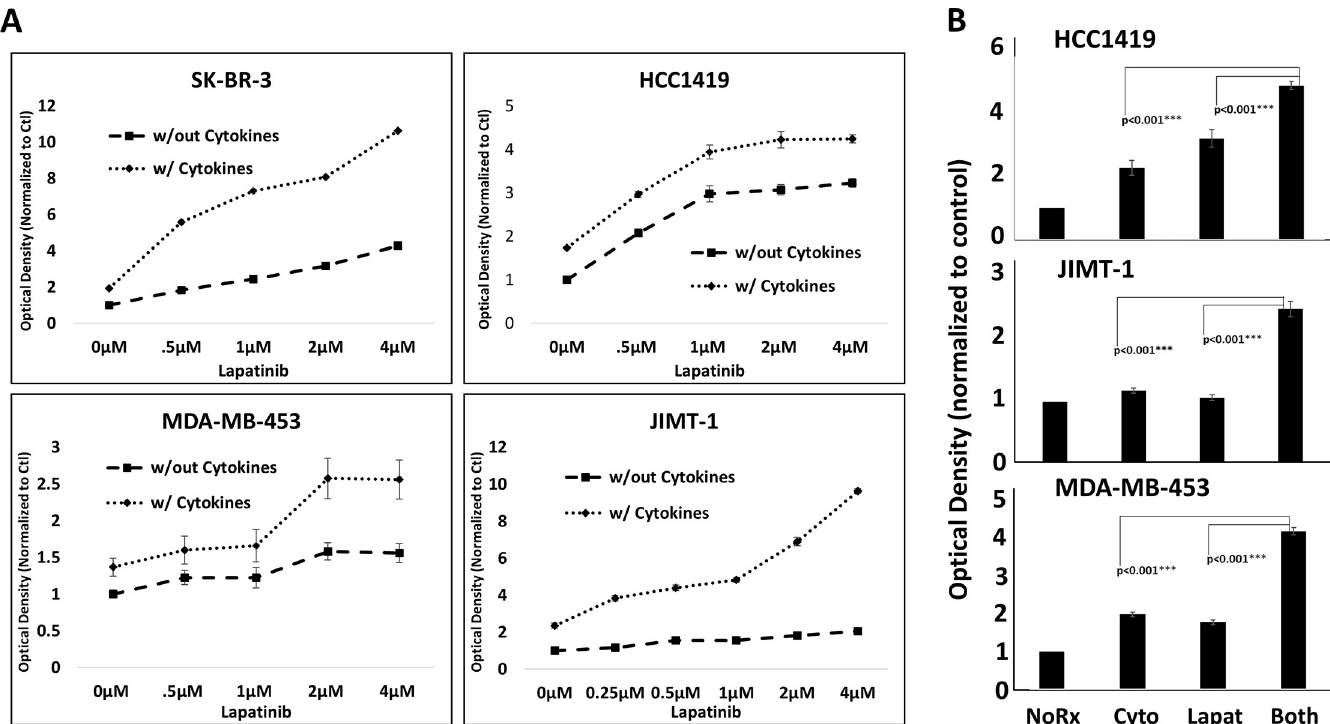
Fig 6. Lapatinib resistant lines are resensitized to drug in the presence of Th1 cytokines. A) Cultured SK-BR-3, HCC1419, JIMT-1, and MDA-MB-453 cells were treated either with Th1 cytokines (TNF- α plus IFN- γ ; 20 and 12.5ng/ml respectively), Lapatinib (0–4 μ M), or Lapatinib plus Th1 cytokines. After 72 hours incubation, resazurin sodium salt was added to each well and further incubated until color change was noted, and optical densities of supernatants read spectrophotometrically at 630nM. B) Statistical analysis at 2 μ m concentration of lapatinib. Shown are composite data from at least three trials per cell line expressed as mean optical density +/- SEM. Statistical significance was determined by one-way ANOVA followed by the Holm-Sidak multiple comparison test.